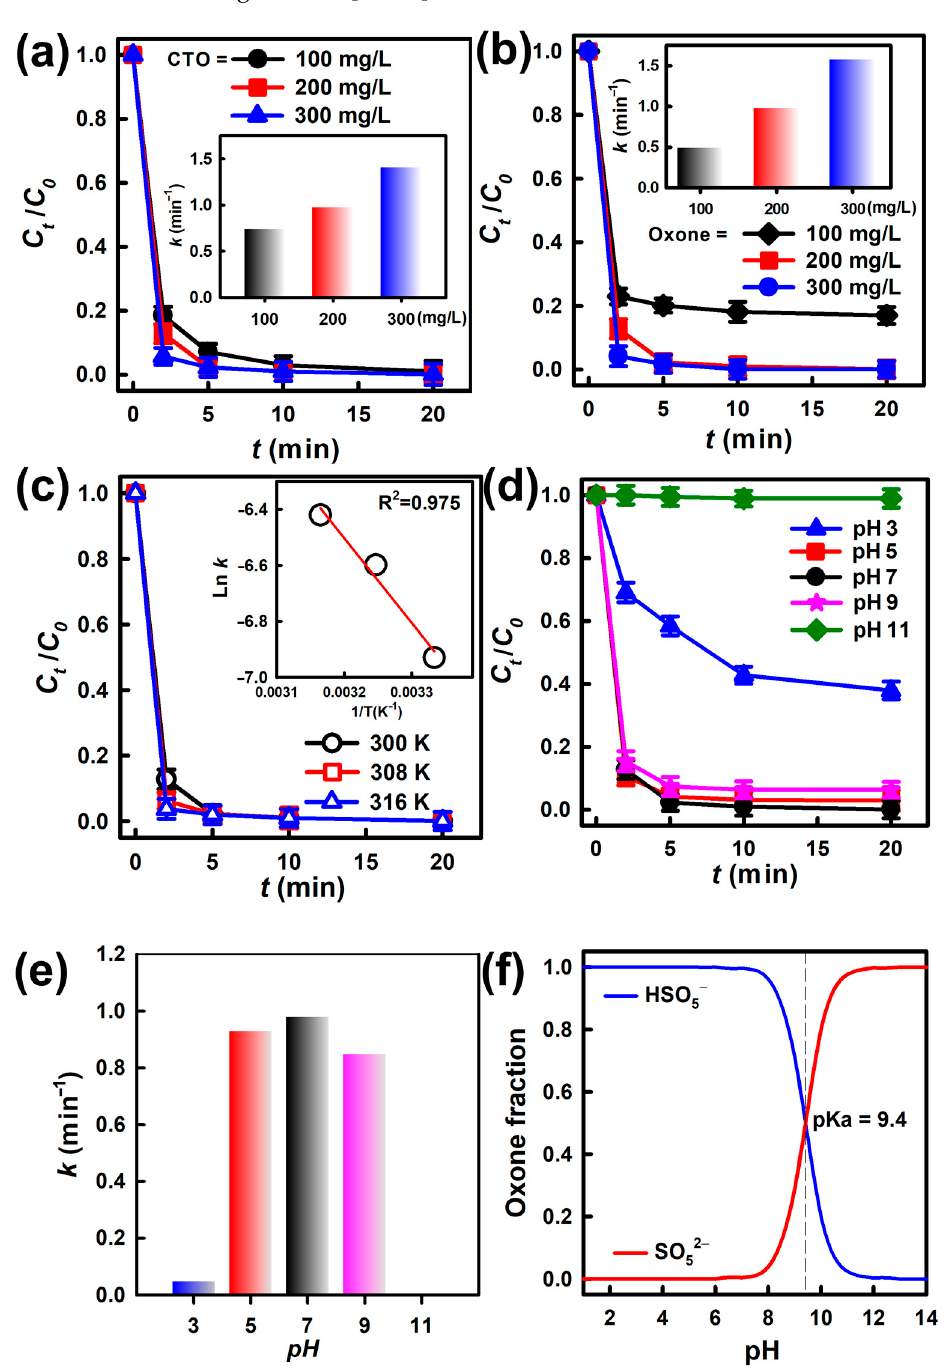
Figure 7. Degradation of BHPM by oxone by CTO + oxone: ( a ) effect of catalyst concentration, ( b ) effect of oxone concentration, ( c ) effect of temperature, and the corresponding plot of Ln k vs. 1/T; ( d ) effect of pH value and the corresponding ( e ) degradation kinetics and ( f ) species of oxone at various pH (catalyst = 200 mg/L; oxone = 200 mg/L; T = 300 K).